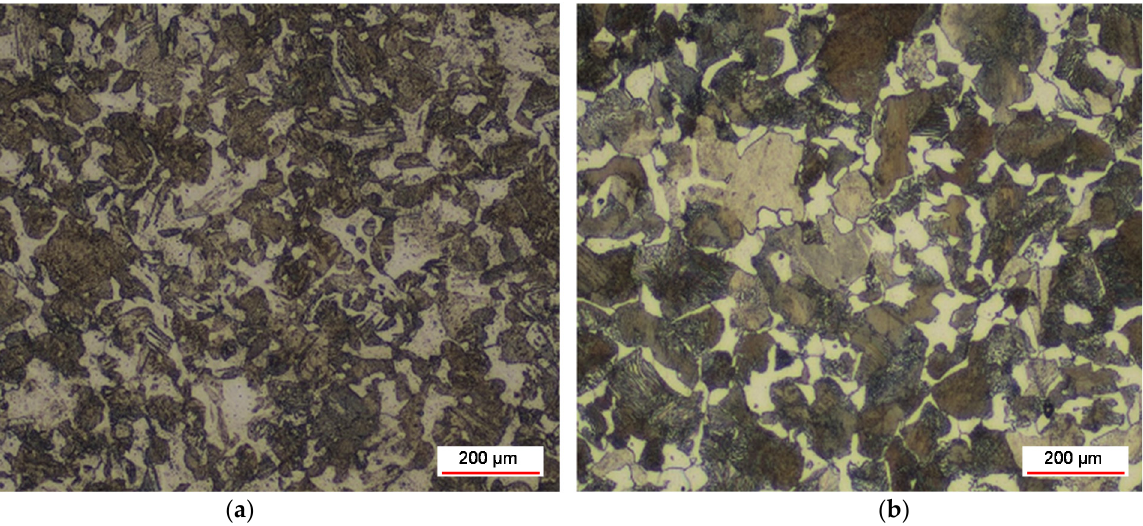
Figure 24. Camshaft core: ( a ) new cam and ( b ) used exhaust cam 2nd cylinder with the smallest